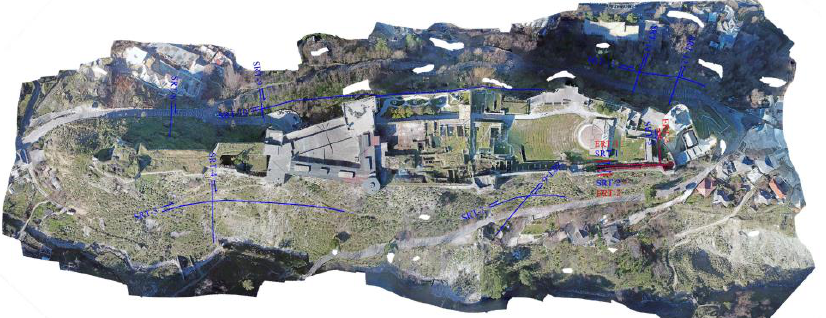
Figure 7. Location of seismic refraction (SRT, in blue) and electrical resistivity tomography (ERT, in red) profiles. (Photo credit: GEA, based on photo by Rand Eppich).